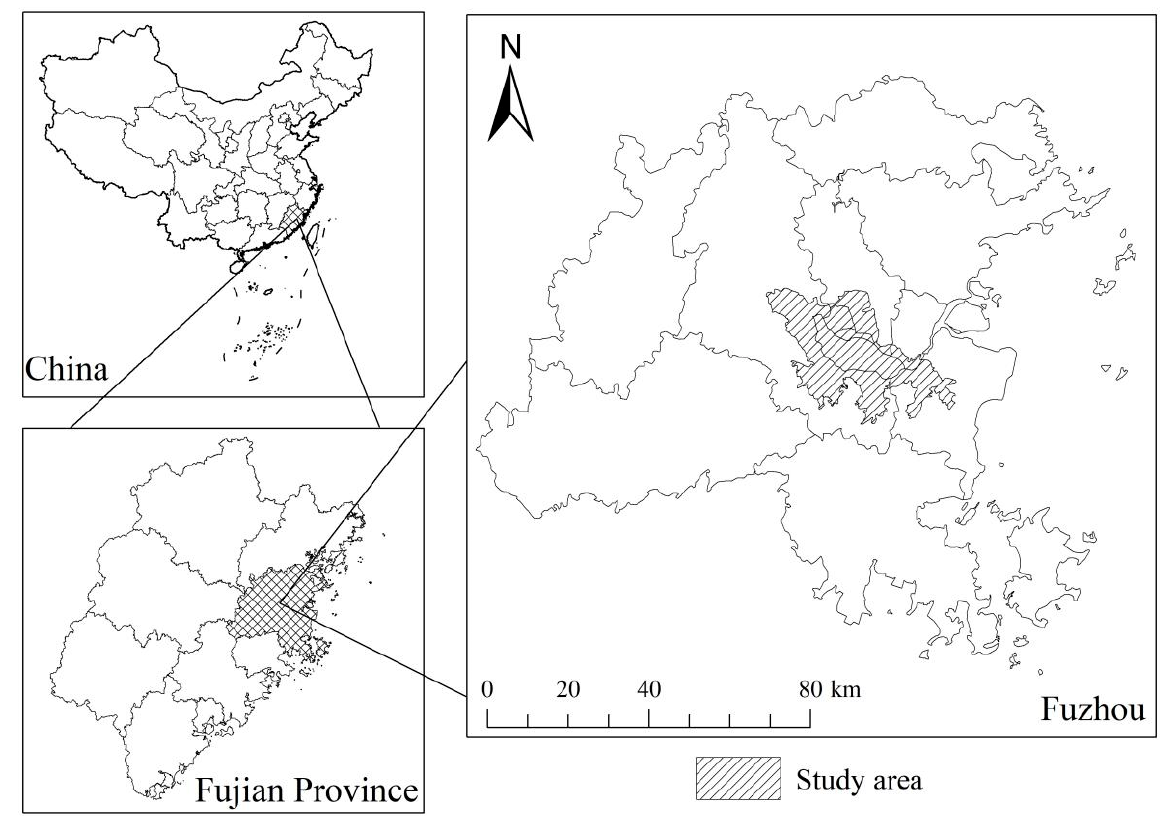
Figure 1. Location of the study area .